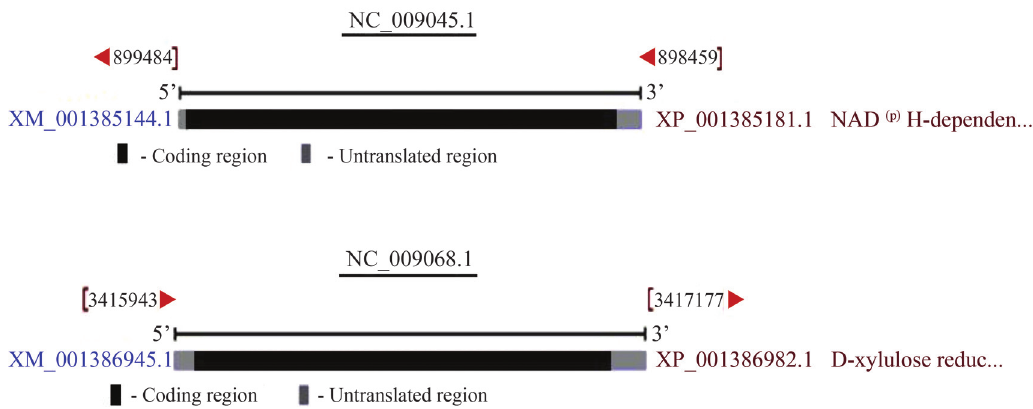
Figure 3 - Exon/intron structures visualization of XR and XDH-encoding-genes of Pichia stipitis .